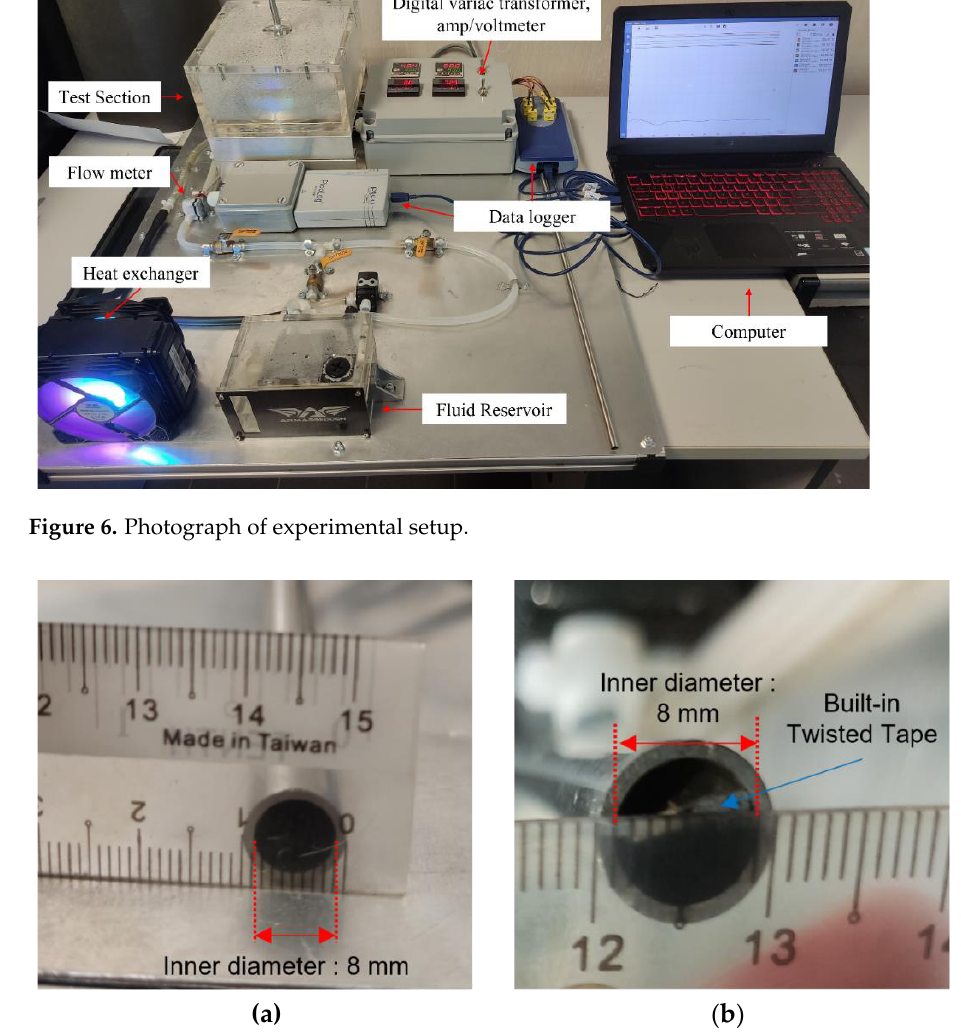
Figure 7. Type of jet impinging nozzles. ( a ) Conventional nozzle, ( b ) twisted tape nozzle.